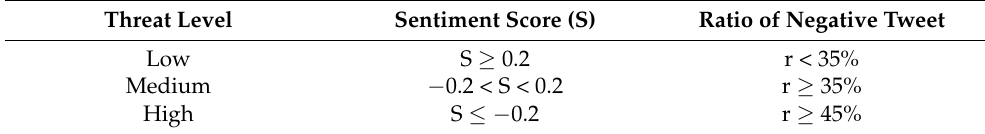
Table 7. Classification of threat